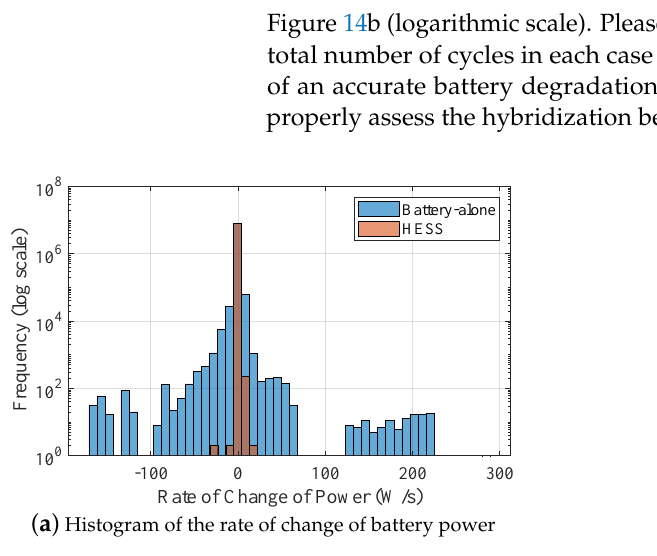
Figure 14. Hybridization effect on the battery